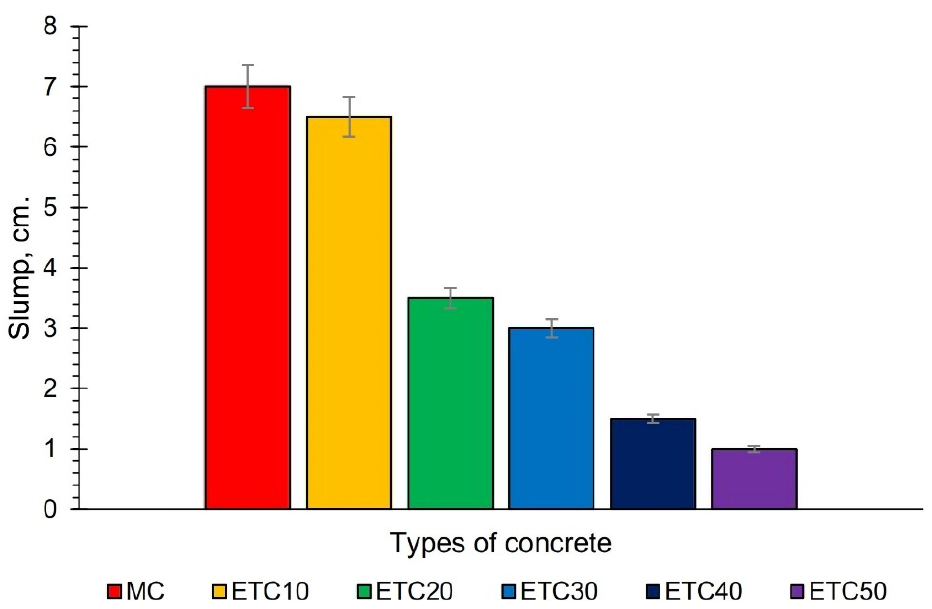
Figure 5. Slump of study mixtures